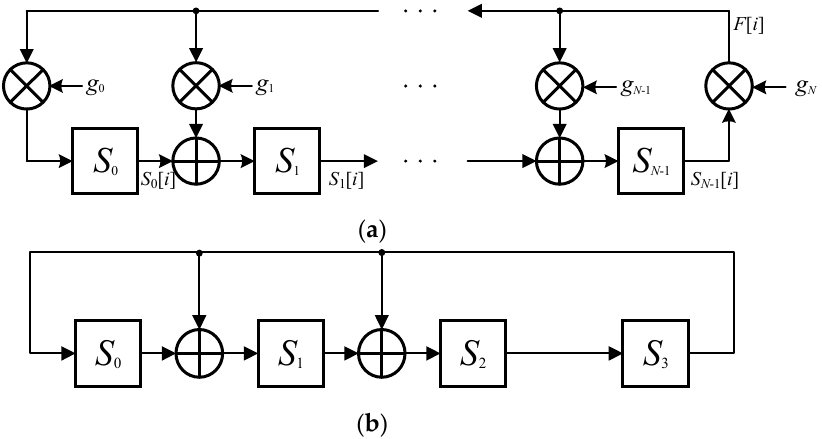
Figure 1. Conventional linear feedback shift register (LFSR). ( a ) General linear feedback shift register; ( b ) Example of LFSR associated with G ( x ) = x 4 + x 2 + x + 1.